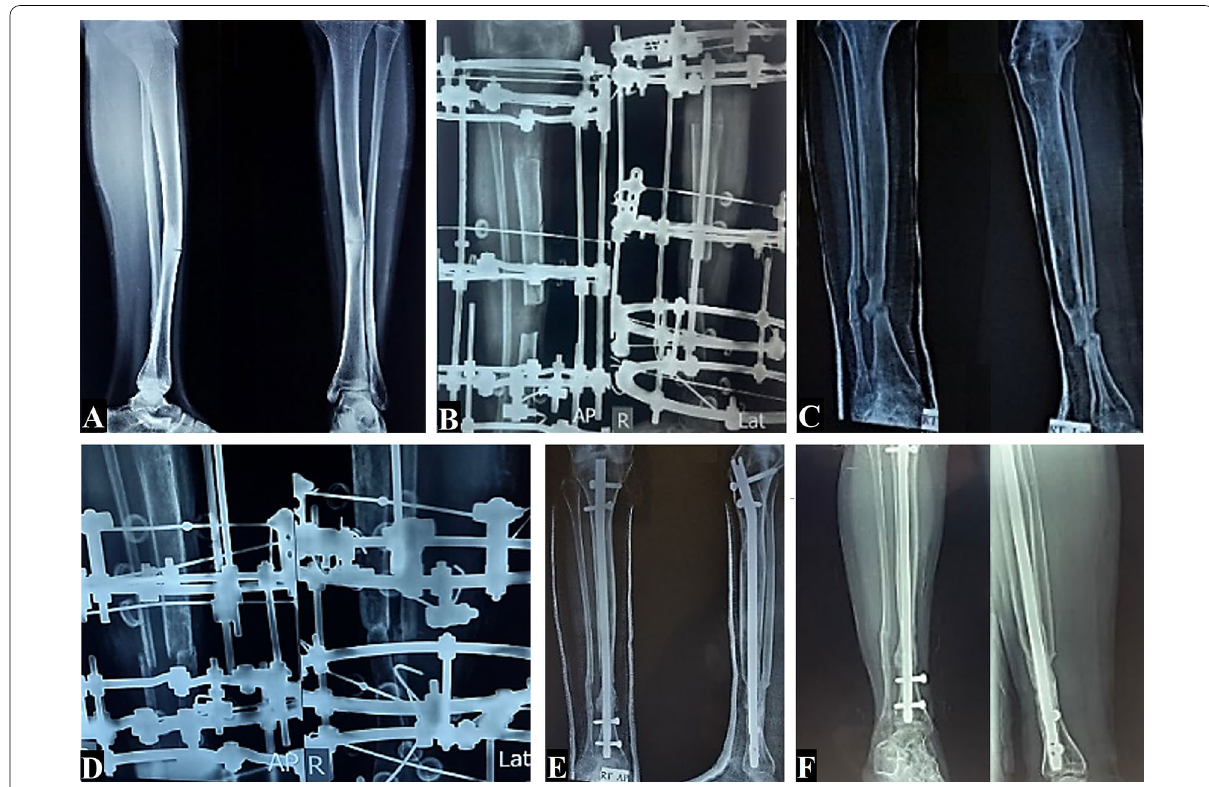
Fig. 1 A 14.5‑year‑old female with congenital segmental tibial dysplasia without pseudarthrosis. A Preoperative AP and lateral X‑rays. B Postoperative AP and lateral X‑rays of Ilizarov segment transport after resection of the diseased segment. C Recurrence of sclerosis and narrow medulla with established pseudarthrosis 4 months post fixator removal. D Revision using another Ilizarov frame after limited debridement. E Maintenance of union by interlocking tibial nail. F AP and lateral X‑rays showing complete union at 5.5 years’